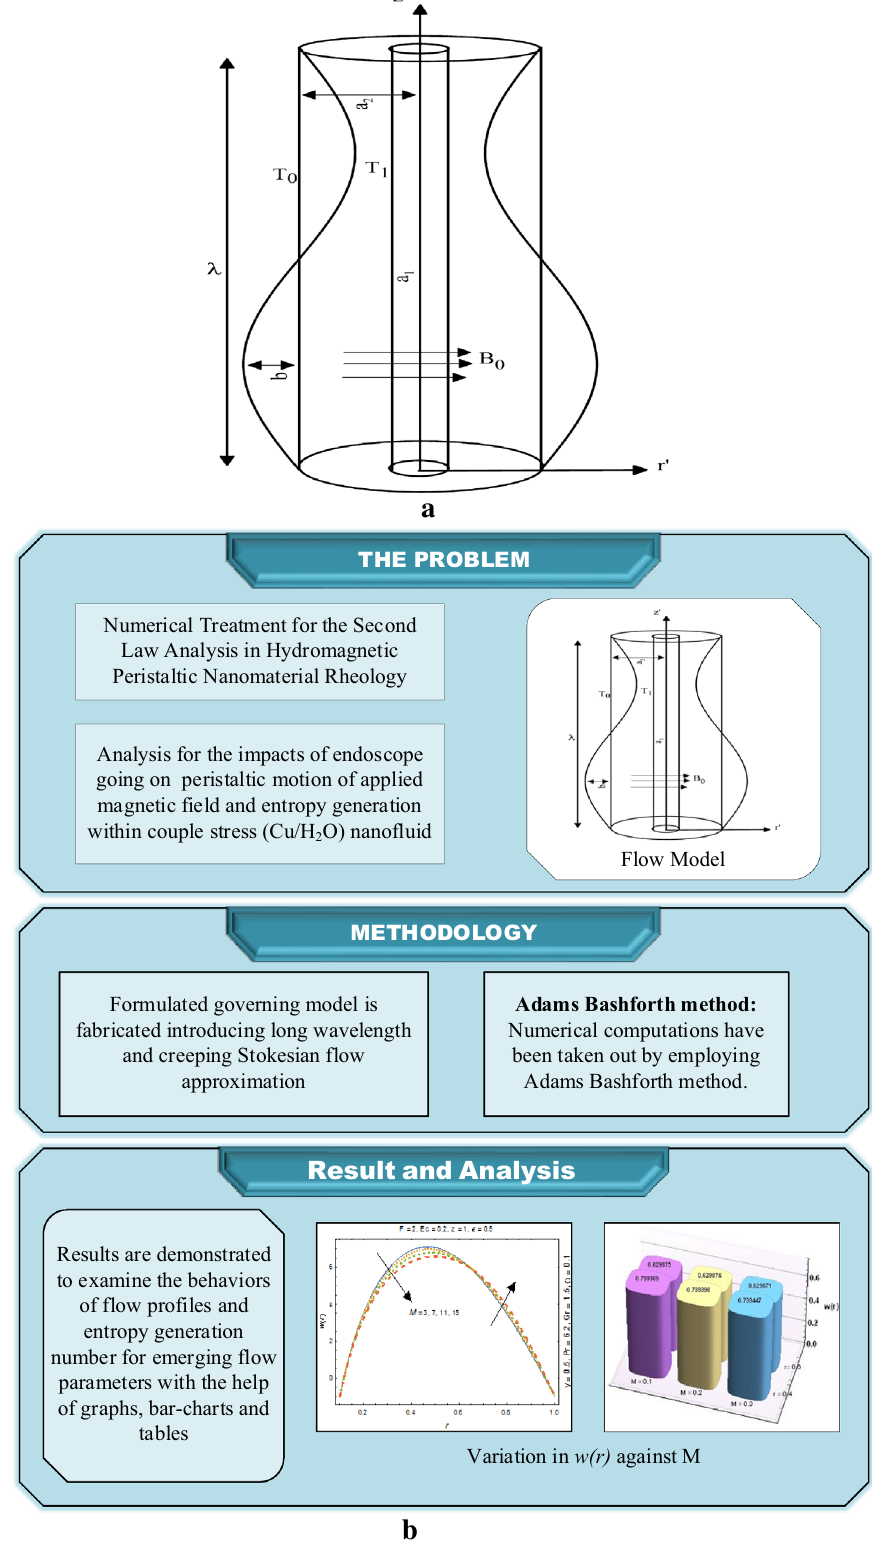
Figure 1. ( a ) Geometrical representation of flow problem. ( b ) Process flow